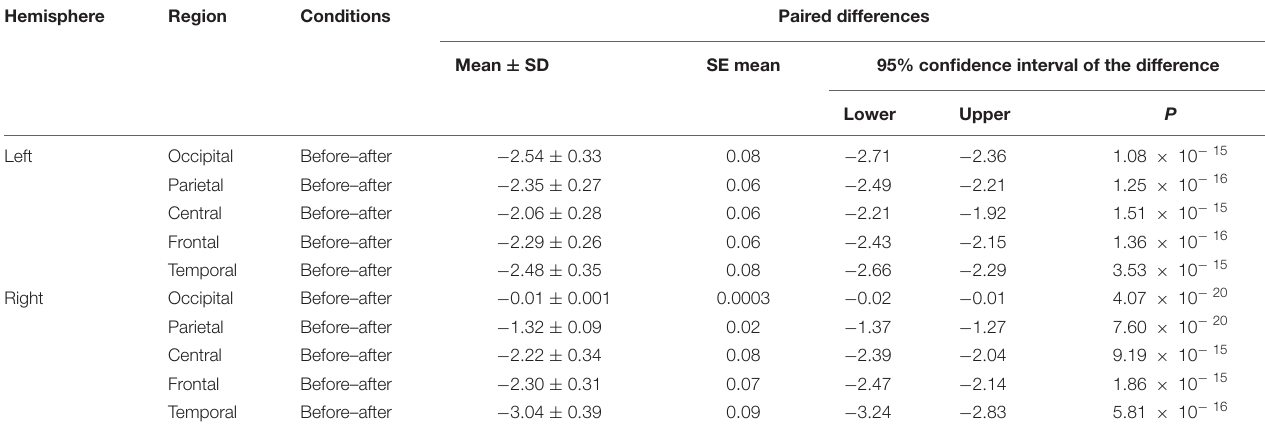
Right Occipital